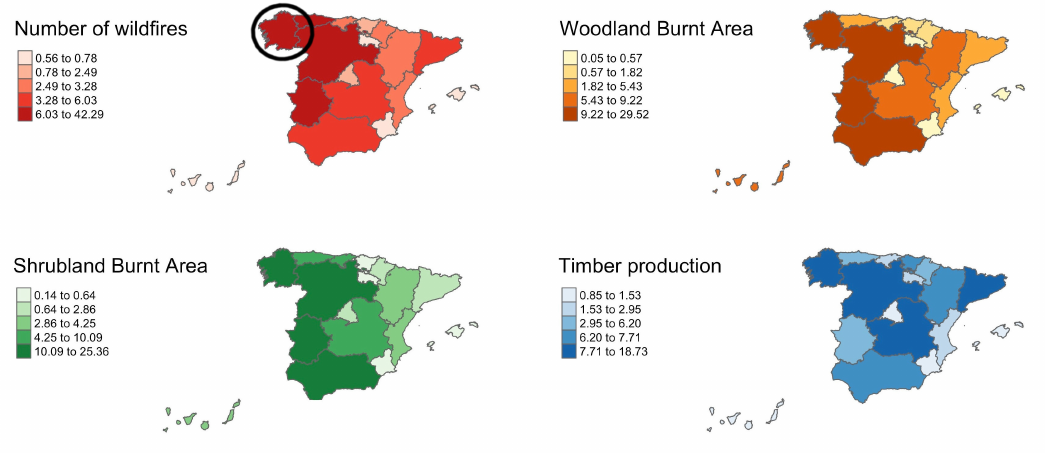
Figure 1. Spatial distribution of fires and wood production in Spain (Galicia is marked with a black circle in the top left figure). Top left: Number of wildfires by region. Top right: Percentage of burned woodland over total forest area. Bottom left: Percentage of burned shrubland over total forest area. Bottom right: Regional timber production ratio. All units are expressed as percentages out of the total for Spain. Note: Distance between mainland Spain and Canary Islands not to scale. (Data obtained from the Spanish Ministry of Agriculture, Fisheries and Food